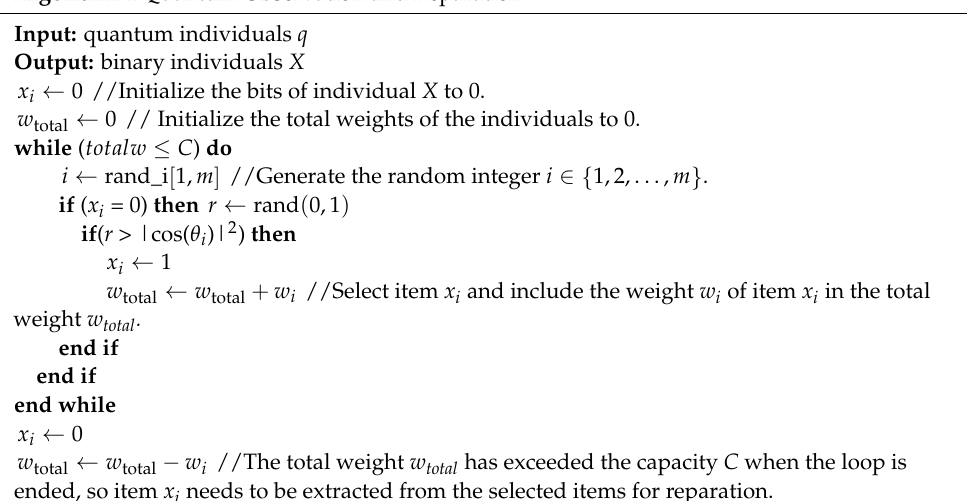
Algorithm 1 Quantum Observation and